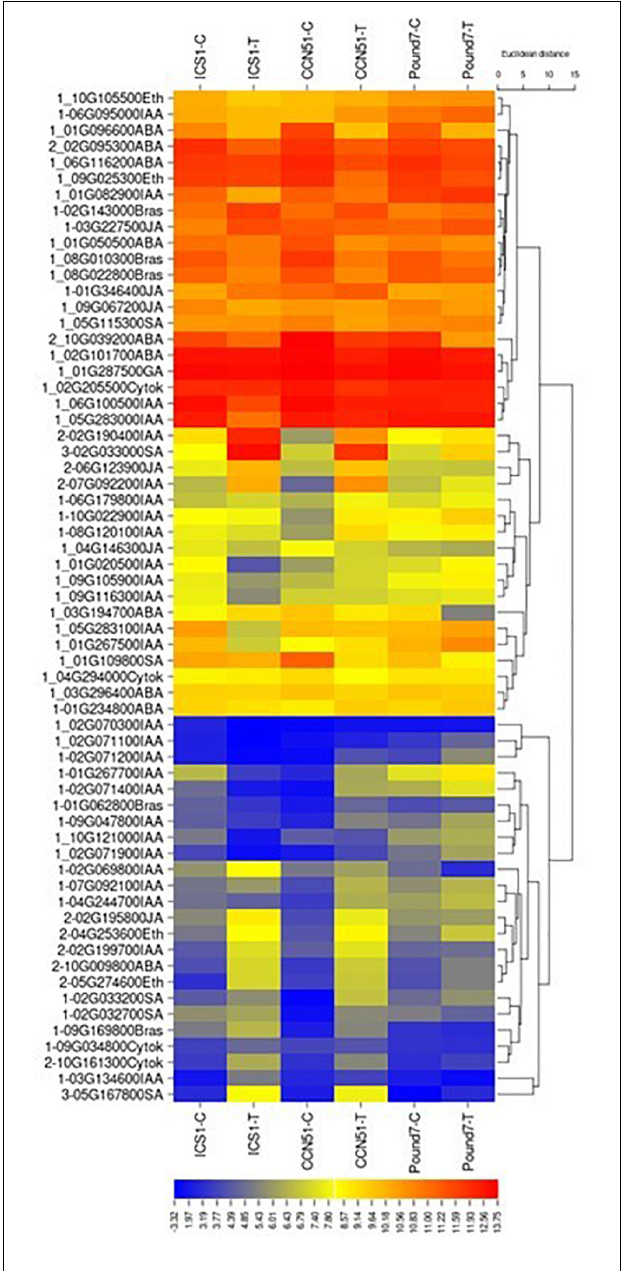
FIGURE 3 | A heat map displaying relative expression levels of cacao genes involved in the Plant Hormone Signal Transduction Pathway (map04075) in young red leaves of ICS1, CCN51, and Pound7 24 h after inoculation with 20- µ l drops of zoospores (0.6 × 10 5 zoospores/ml). Initial numbers indicate the number of genotypes with significant differential expression between treated and control samples. The following – and _, indicate upregulated, downregulated genes, respectively. The following numbers represent gene identifications in the cacao transcriptome ( Supplementary Data Sheet 1 ). Terminal letters indicate hormone/pathway.